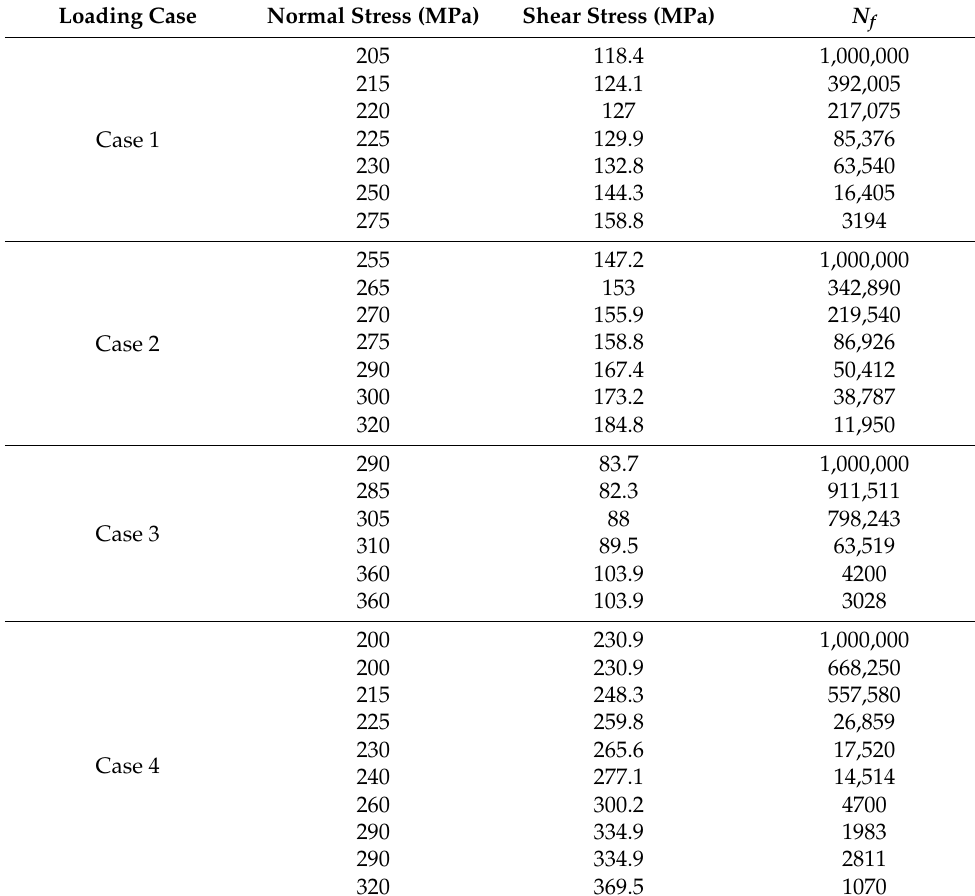
Table 3. AISI 303 multiaxial experimental fatigue data, cases 1 to